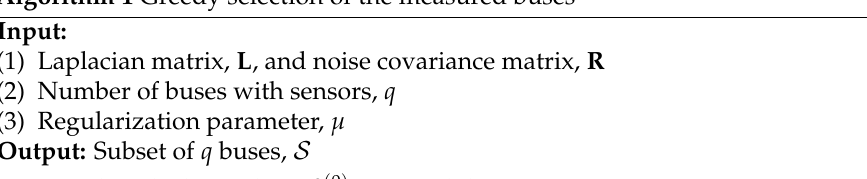
Figure 4. Flow of the proposed GSP greedy selection of the measured buses (Algorithm 1). Algorithm 1 Greedy selection of the measured